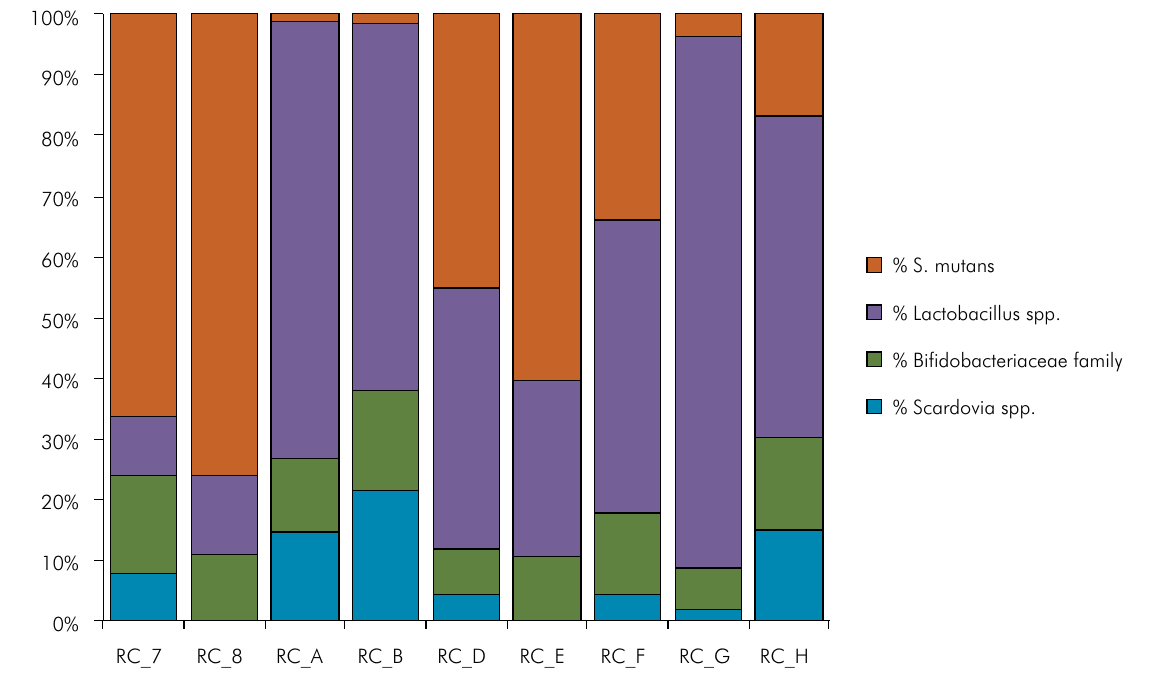
Figure 2. Proportion of reads of Scardovia spp., Bifidobacteriaceae members, Lactobacillus spp. and Streptococcus mutans in the metatranscriptome of root caries biofilms (pipeline a).